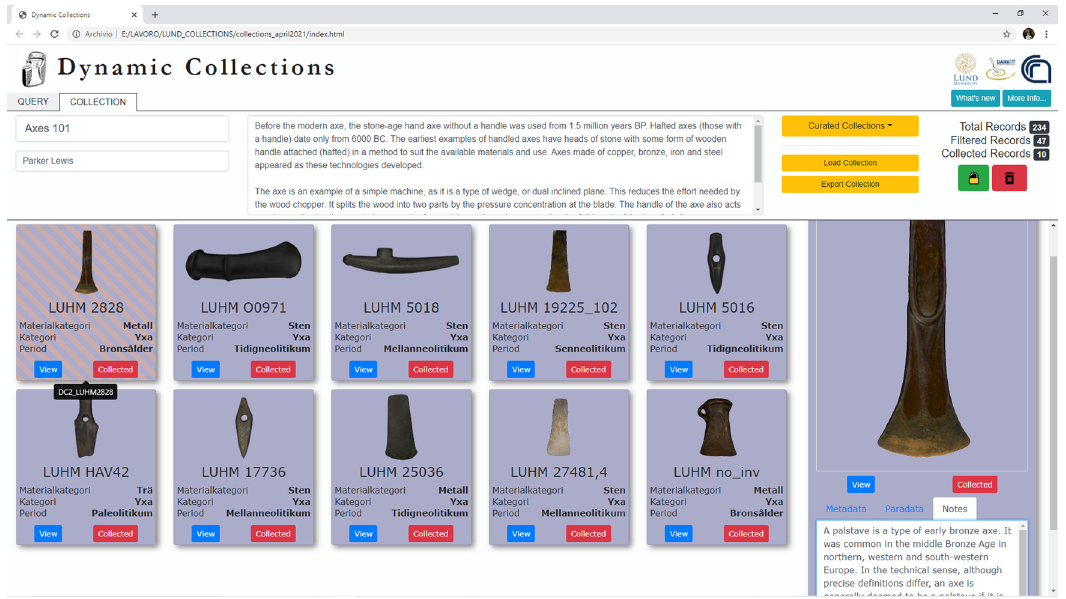
Figure 8: The collection interface. Here are listed the objects collected from the database - like interface. Users may give their collections a name and add notes at collection and object level. Here, collections may be saved and loaded in JSON format, or the user might access one of the curated collections .